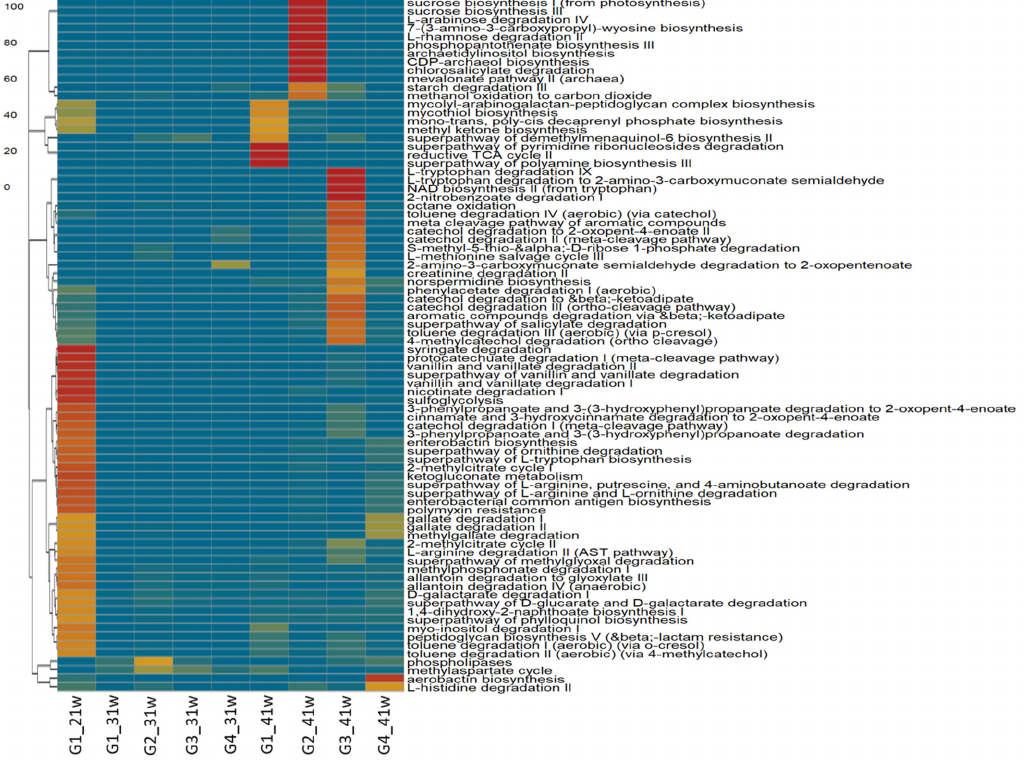
Figure 3. Heatmap representing the functional profiles of fecal-associated bacterial communities predicted by PICRUSt2 and MetaCyc. G1: Control group; G2: Salmonella -phytobiotic-supplemented unchallenged hens; G3: Salmonella -phytobiotic-supplemented challenged hens; G4: Salmonella -chal- lenged hens. Samples were obtained from hens at 21, 31, and 41 weeks of age (21 w, 31 w, and 41 w, respectively). The number of hens for each treatment was 48. Finally, correlation analysis showed that the relative abundance of the Firmicutes phylum , strongly represent in the fecal microbiota, correlated with the relative frequency of the main productive parameters and egg quality. For example, Firmicutes positively correlated ( p < 0.05) with egg production and feed conversion index ratio and negatively correlated with yolk color and egg shell thickness. The Bacterioidetes positively correlated ( p < 0.05) with egg weight and albumin height; on the other hand, this phylum negatively correlated with egg production, egg shell strength, and egg shell thickness (Figure 4).